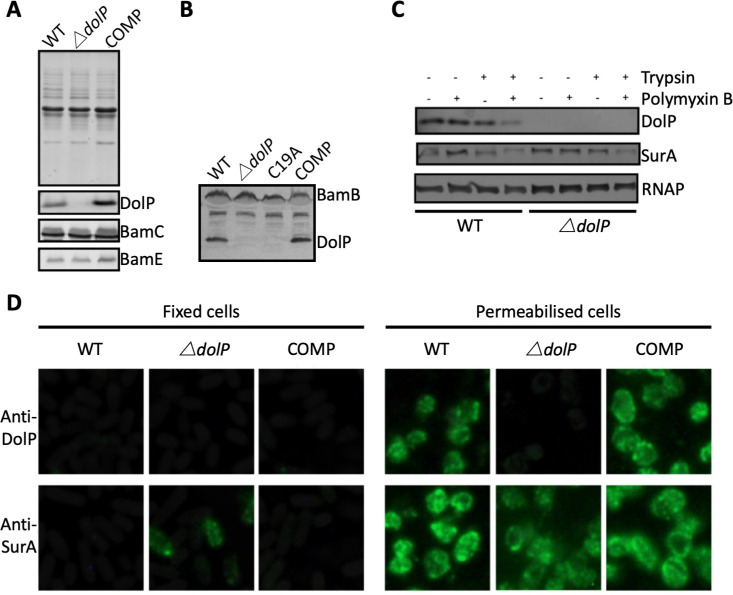
DolP is an OM lipoprotein.(A) OM fractions of E. coli BW25113, an isogenic ∆dolP mutant and the complemented mutant were analysed by SDS-PAGE and Western immunoblotting with antibodies to DolP and the known OM lipoproteins BamC and BamE. DolP is not detected in the mutant but like BamC and BamE is found with the membrane fraction. (B) Western immunoblotting of OM fractions from E. coli ∆dolP complemented with a plasmid (pDolP-C19A) encoding DolP with a point mutation at position C19. (C) E. coli cells treated with protease in the presence (+) or absence (-) of polymyxin B, which permeablises the OM, allowing the protease access to the periplasm. Antibodies to the cytoplasmic RNA polymerase (RNAP) and the periplasmic chaperone SurA were used as controls. (D) Immunofluorescence photomicrographs of E. coli BW25113, an isogenic ∆dolP mutant and the complemented mutant. Cells were probed with anti-DolP before and after permeabilisation. Anti-SurA was used as a control.Figure 1—figure supplement 1—source data 1.Subcellular localisation of DolP.